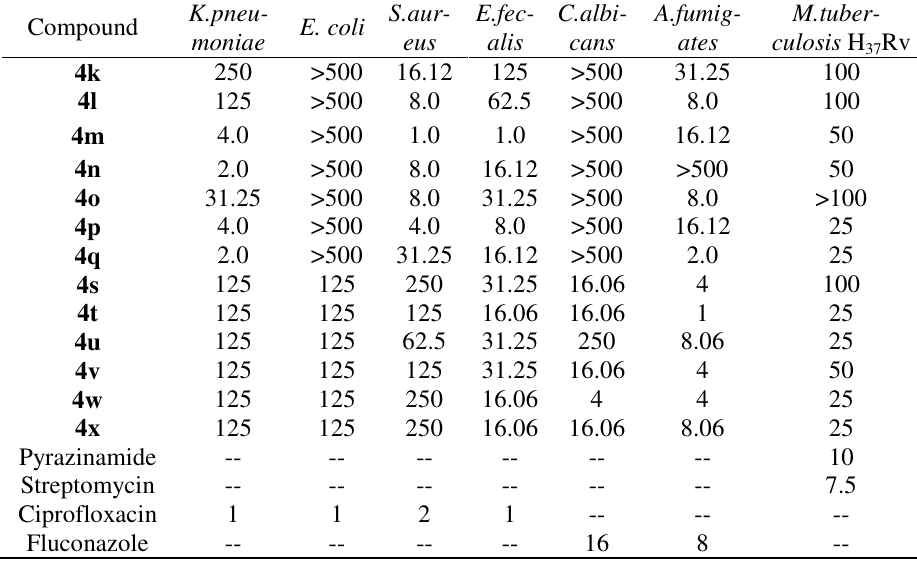
Table 1. Antitubercular, antibacterial and antifungal activities of compounds ( 4k-4q & 4s - 4x ) (MIC in µg mL -1